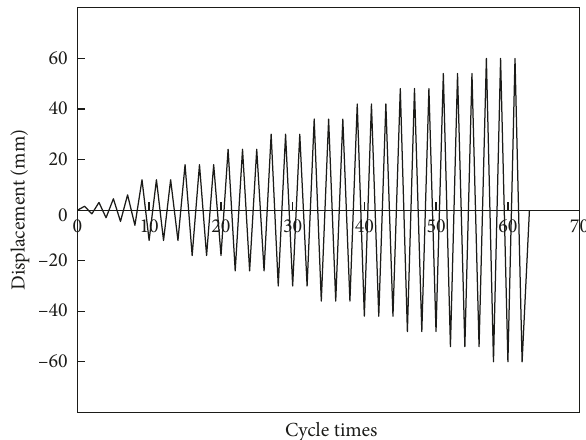
Figure 3: Sketch of loading scheme.